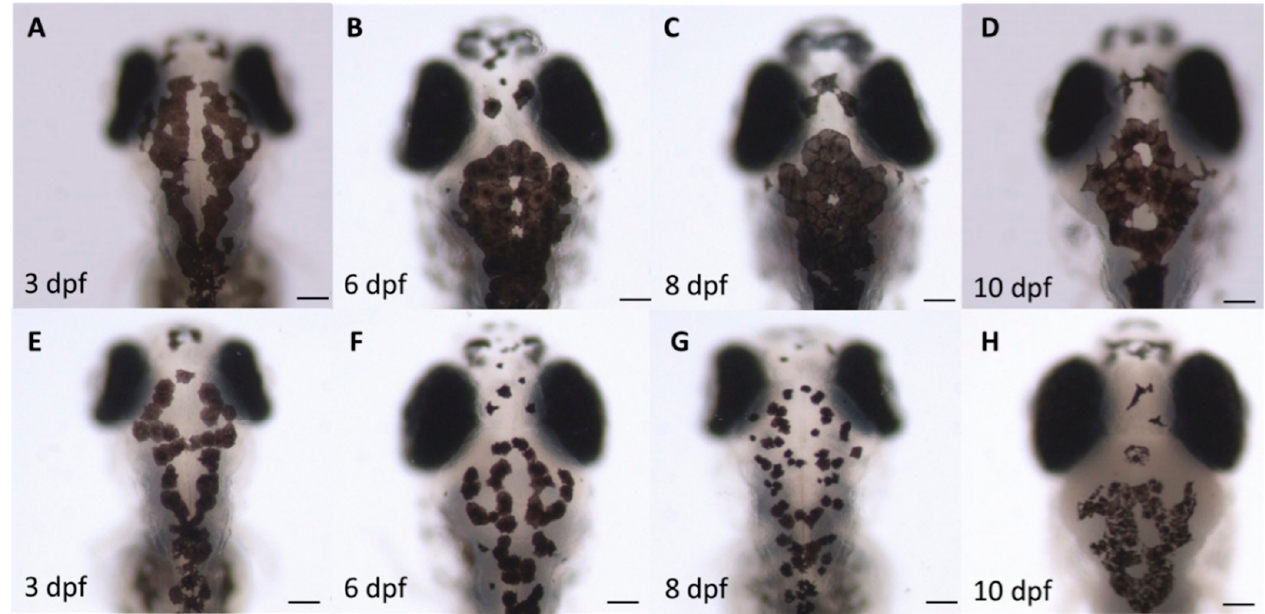
Figure 6. Comparison of the melanocyte density and morphology of the ( A – D ) control and ( E – H ) 1% alcohol-treated zebrafish embryos at 3, 6, 8 and 10 days post-fertilisation (dpf). The images illustrate the difference in melanocyte development in 1% alcohol-treated samples compared with control samples of each life stage, with defects in melanogenesis; melanin dispersion; and melanocyte surface area, arrangement and density. Scale bar: 100 µ